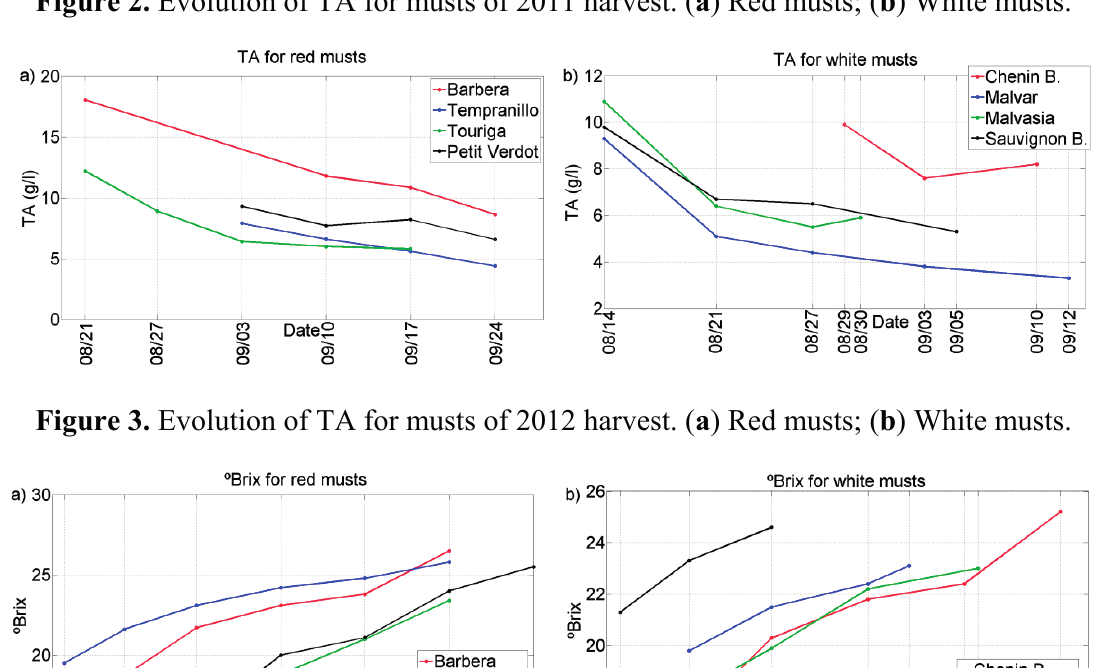
Figure 2. Evolution of TA for musts of 2011 harvest. ( a ) Red musts; ( b ) White musts.